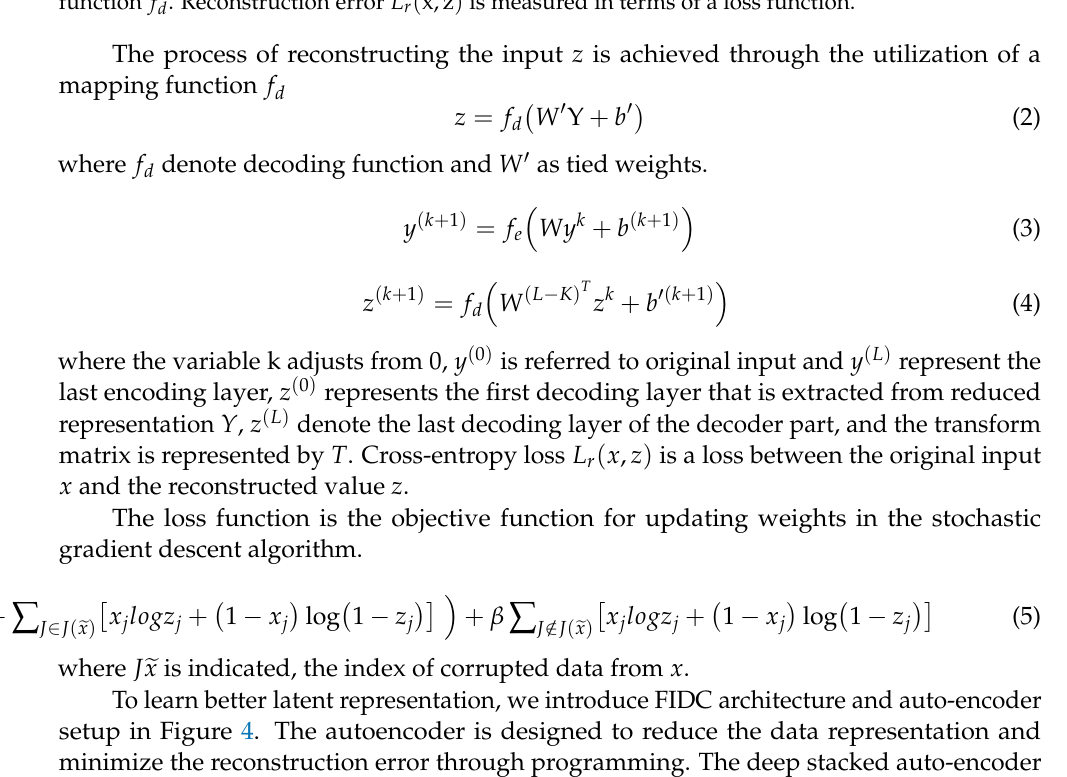
where the reduced representation code is represented by the symbol 𝑦 , the weight of the input to the hidden layer is represented by 𝑊 , bias as 𝑏 , and 𝑓 (cid:3032) is relu activation function for encoder/decoder hidden layers [42].